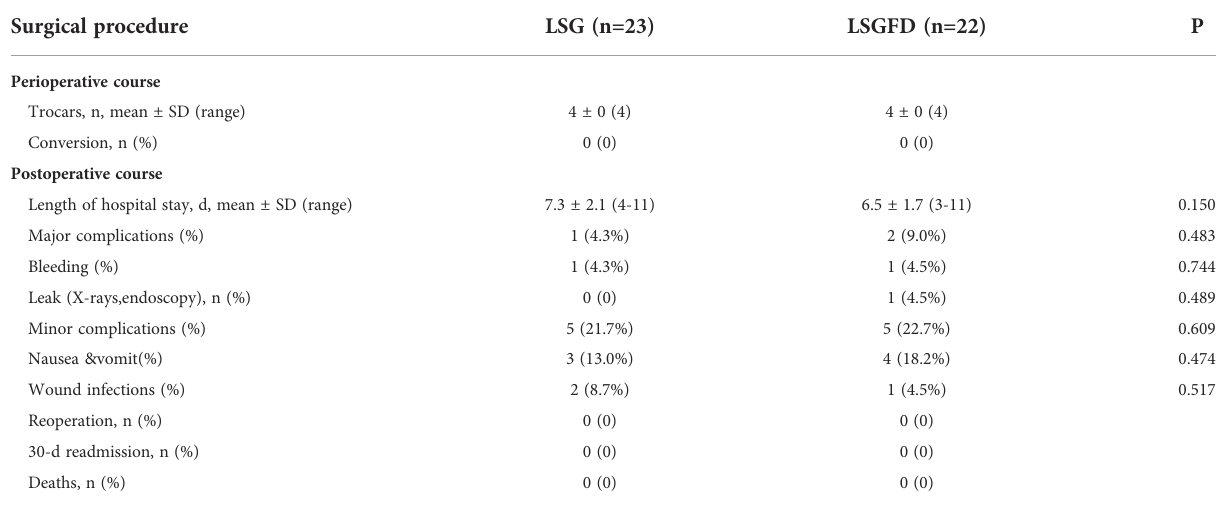
TABLE 2 Perioperative and postoperative data.